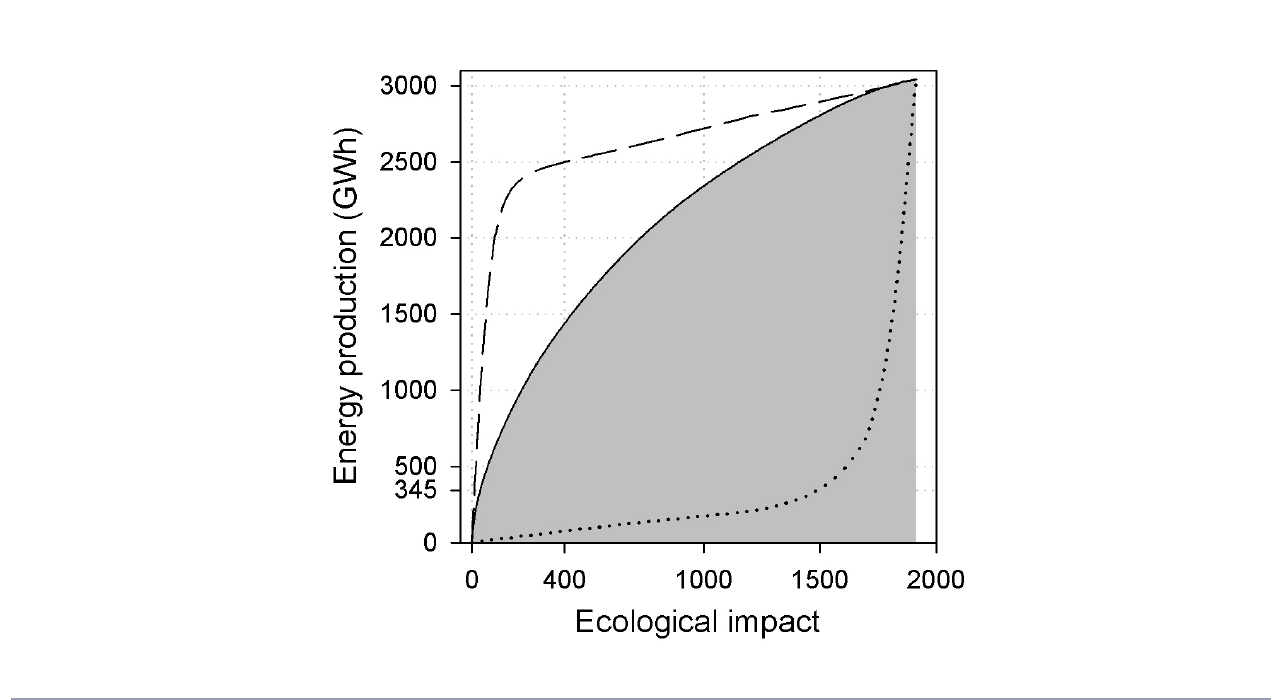
Fig. 6 . Efficiency frontier. Energy production versus ecological impact. The solid line is as calculated for the study region, dashed and dotted lines are two fictitious efficiency frontiers. Shaded area: the area (AUC) under the solid efficiency